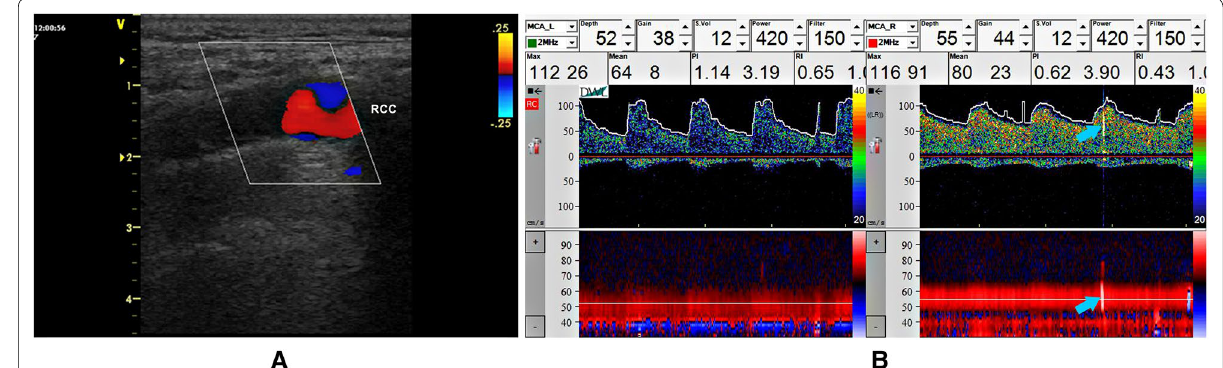
Fig. 1 a Suggestive image of a plaque in the right common carotid artery (rcca); b in the same patient, spontaneous microembolic signal was detected by transcranial Doppler monitoring in acute phase of stroke. Blue arrows indicate MES in wave spectrum and in Mode